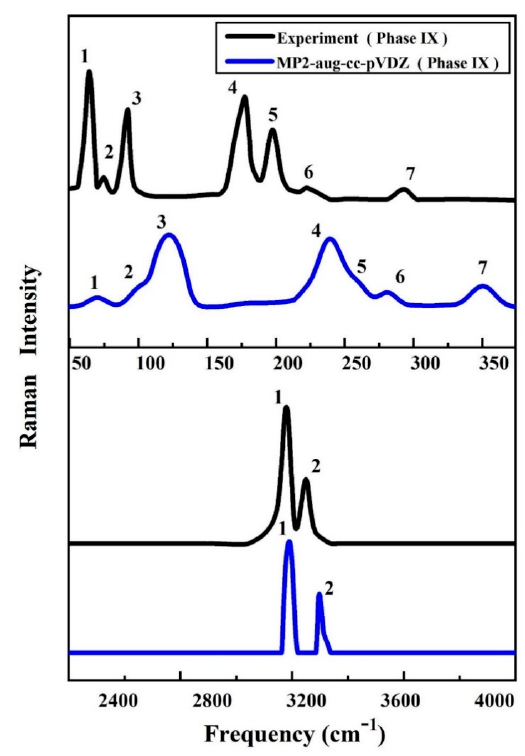
Figure 2. The calculated and observed Raman spectra of ice phase IX in liberational frequency (low frequency) and stretching frequency (high frequency) regions at 0.28 GPa. The calculation is carried out using EE-GMF-MP2 / aug-cc-pVDZ, while the observed Raman spectra are taken from Ref. [46–49].